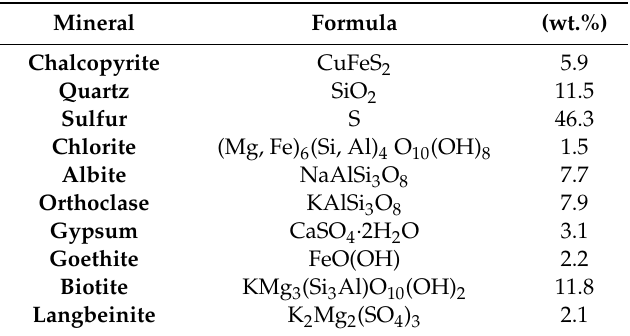
Table 7. Mineral composition of the residue (Test